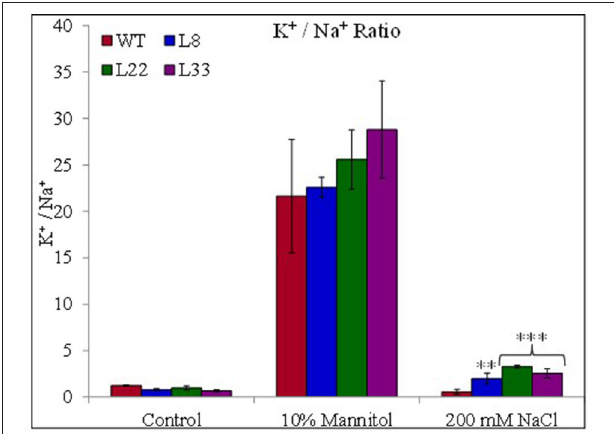
FIGURE 11 | Ionic contents. Comparison of sodium-potassium ratio in WT and transgenic tobacco under control and stress (drought and salt) conditions. The ** and *** denote statistical significance in responses of transgenic lines against control at P value ≤ 0.01 and 0.001